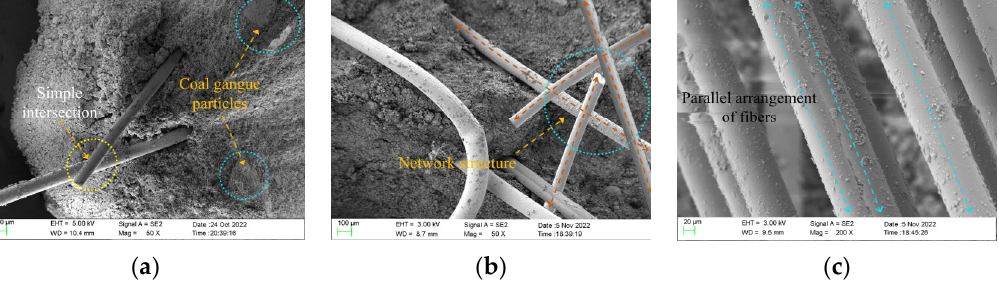
Figure 14. The micro-morphology of samples with different fiber content. ( a ) Sample 5 (4%). ( b ) Sample 10 (5%). ( c )Sample 13 (6%).